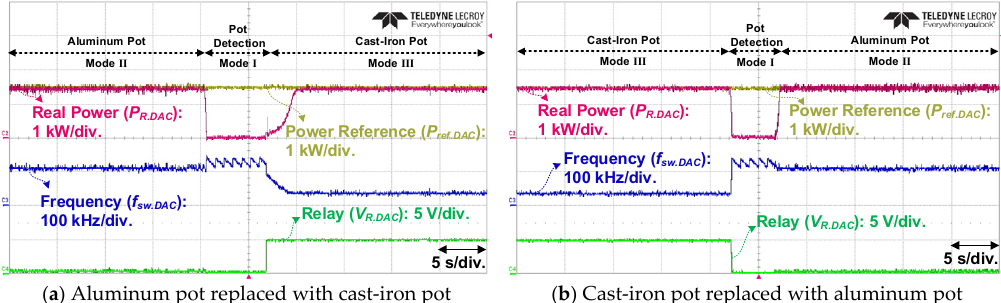
Figure 20. Waveforms obtained for pot-replacement and detection experiments.